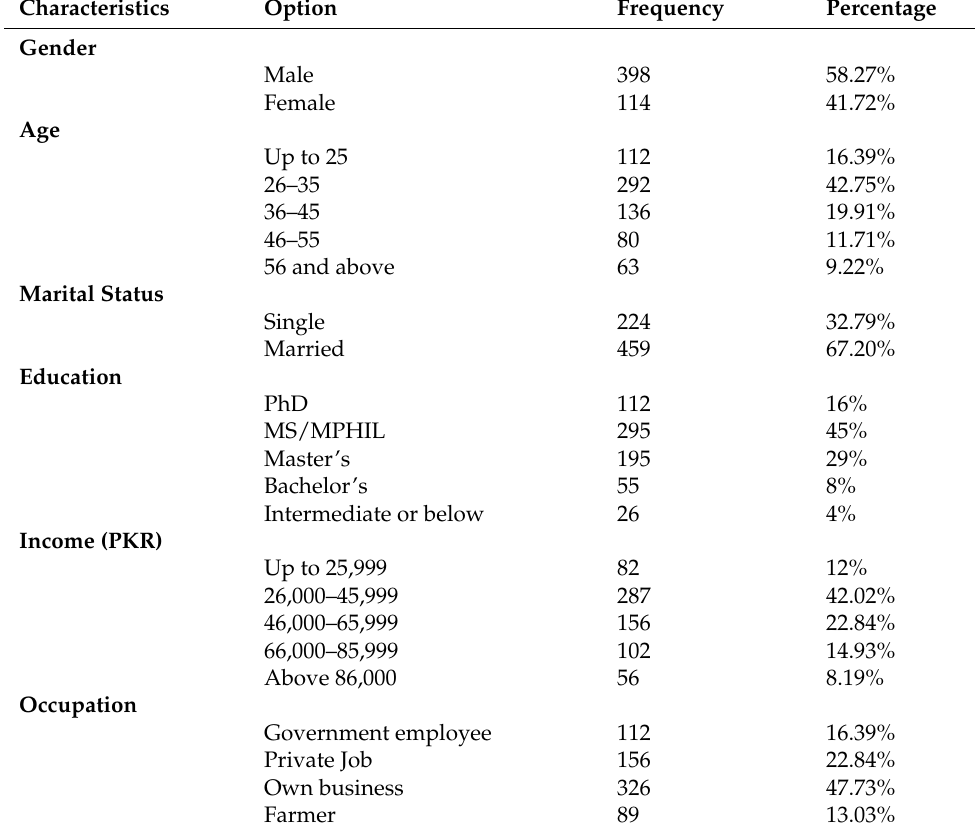
Table 5. Respondents profile N =